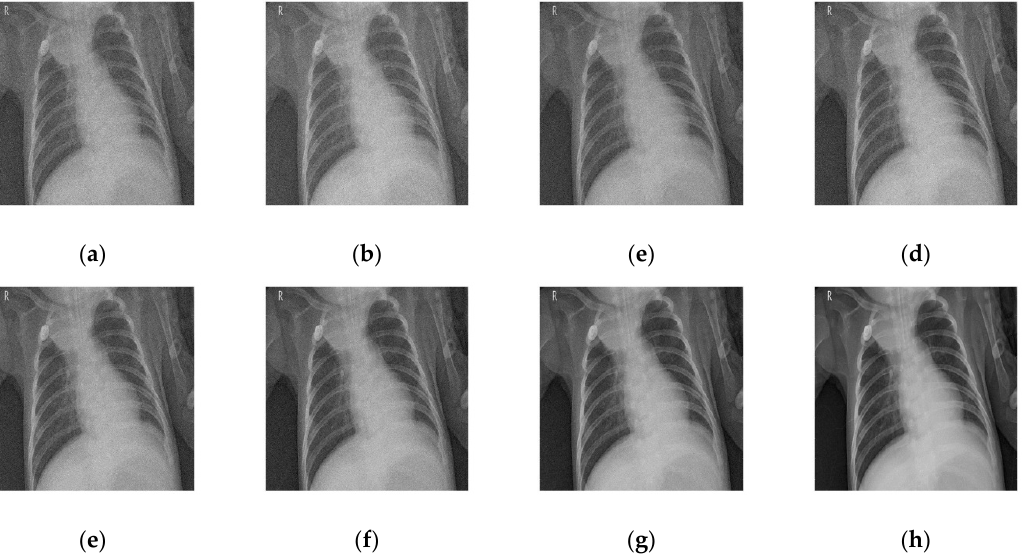
Figure 5. Denoised COVID-19 CT image 2 for the ( a ) [10], ( b ) [11], ( c ) [12], ( d ) [13], ( e ) [14], ( f ) [11], ( g ) [16], and ( h ) proposed frameworks, respectively.